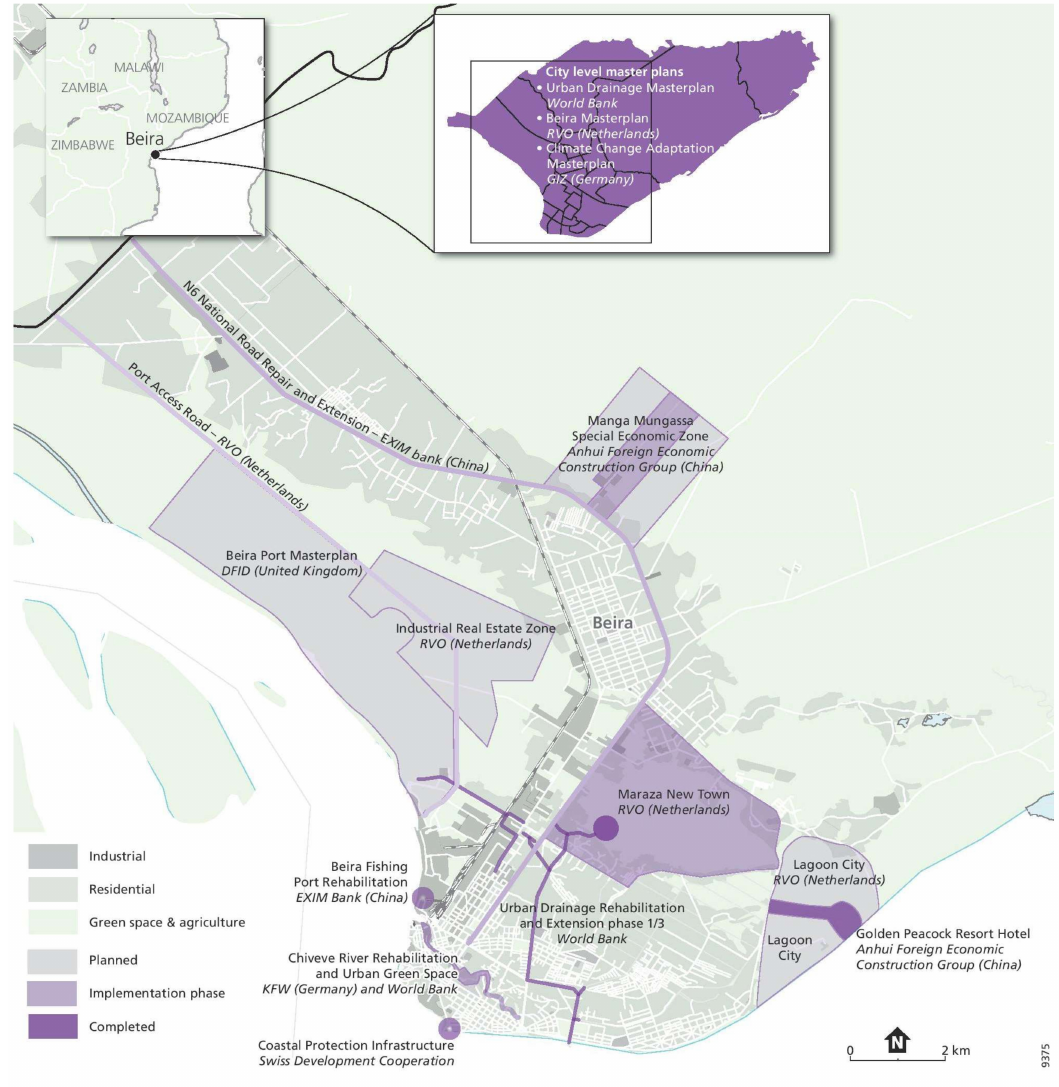
Figure 1. Land use patterns and the spatial implications of recent (proposed) interventions in the built environment in Beira with funding from international